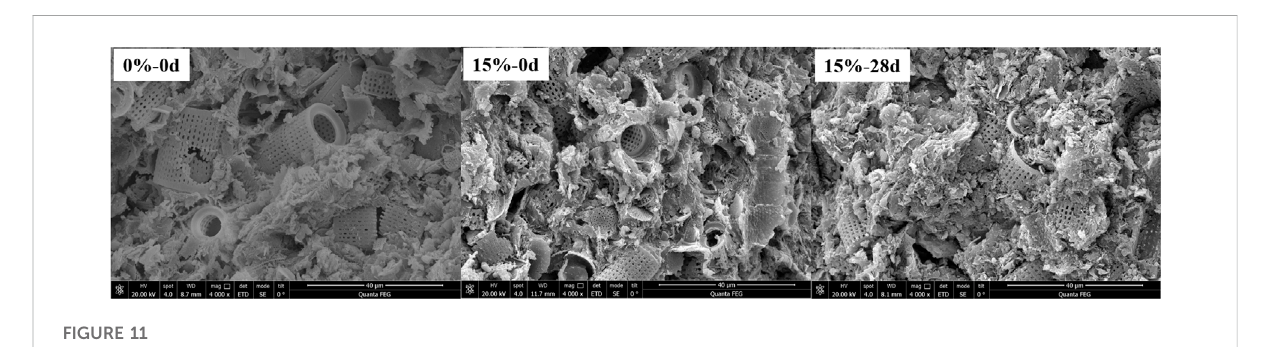
FIGURE 11 SEM of cement modi fi ed